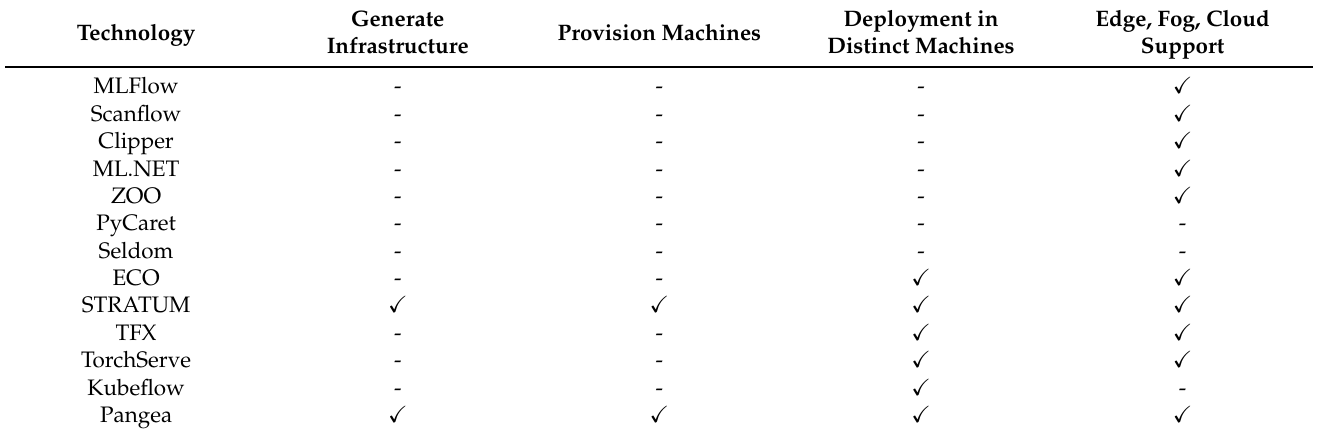
Table 2. Related work compared against the main functionalities of Pangea. (cid:88) symbol means that the technology satisfies the